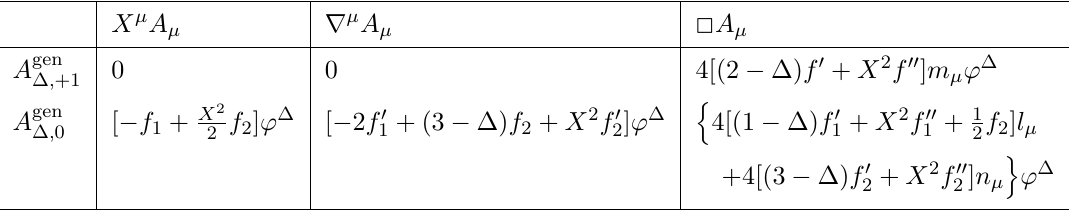
Table 6. Various constraints one can impose on a generalized conformal primary